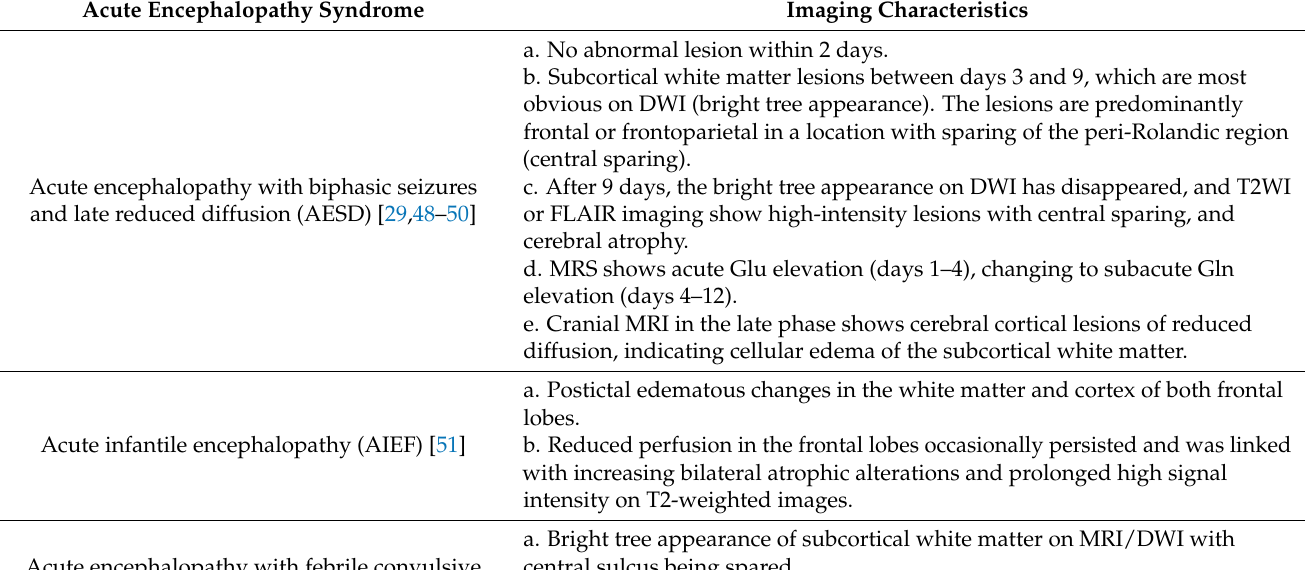
Table 2. MRI/CT characteristics of acute